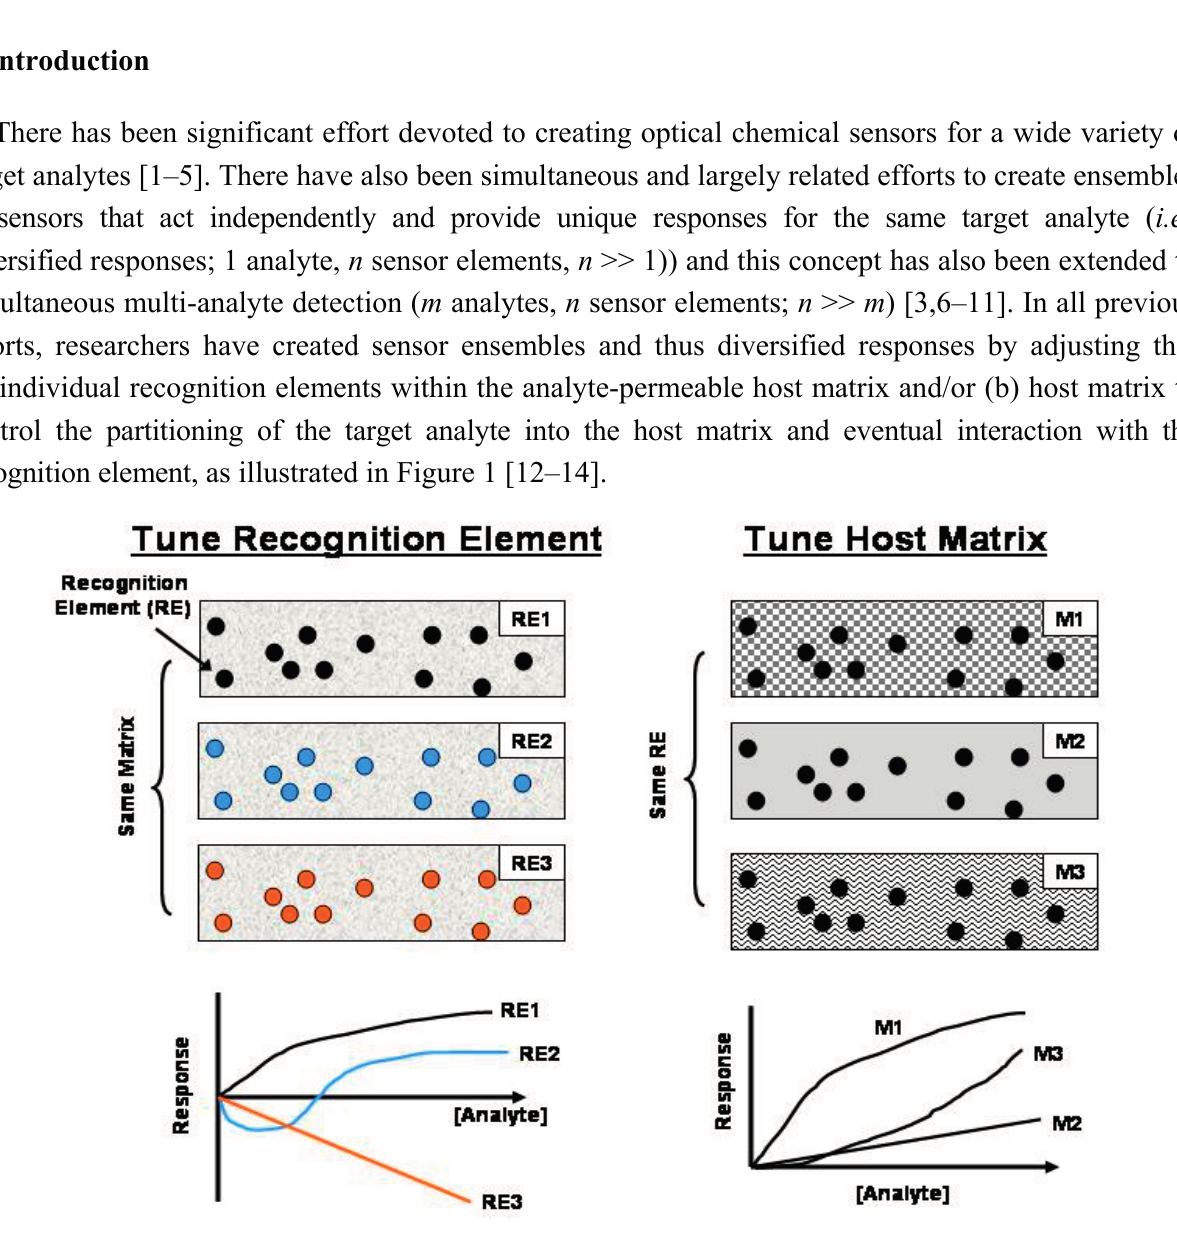
Figure 1. Illustration that describes traditional approaches of creating chemical sensors with a range of response profiles for the same target analyte. Three hypothetical sensor elements are shown under each approach. Each sensor yields a unique response profile for the intended target analyte that depends on the recognition element (RE x ) or matrix (M x